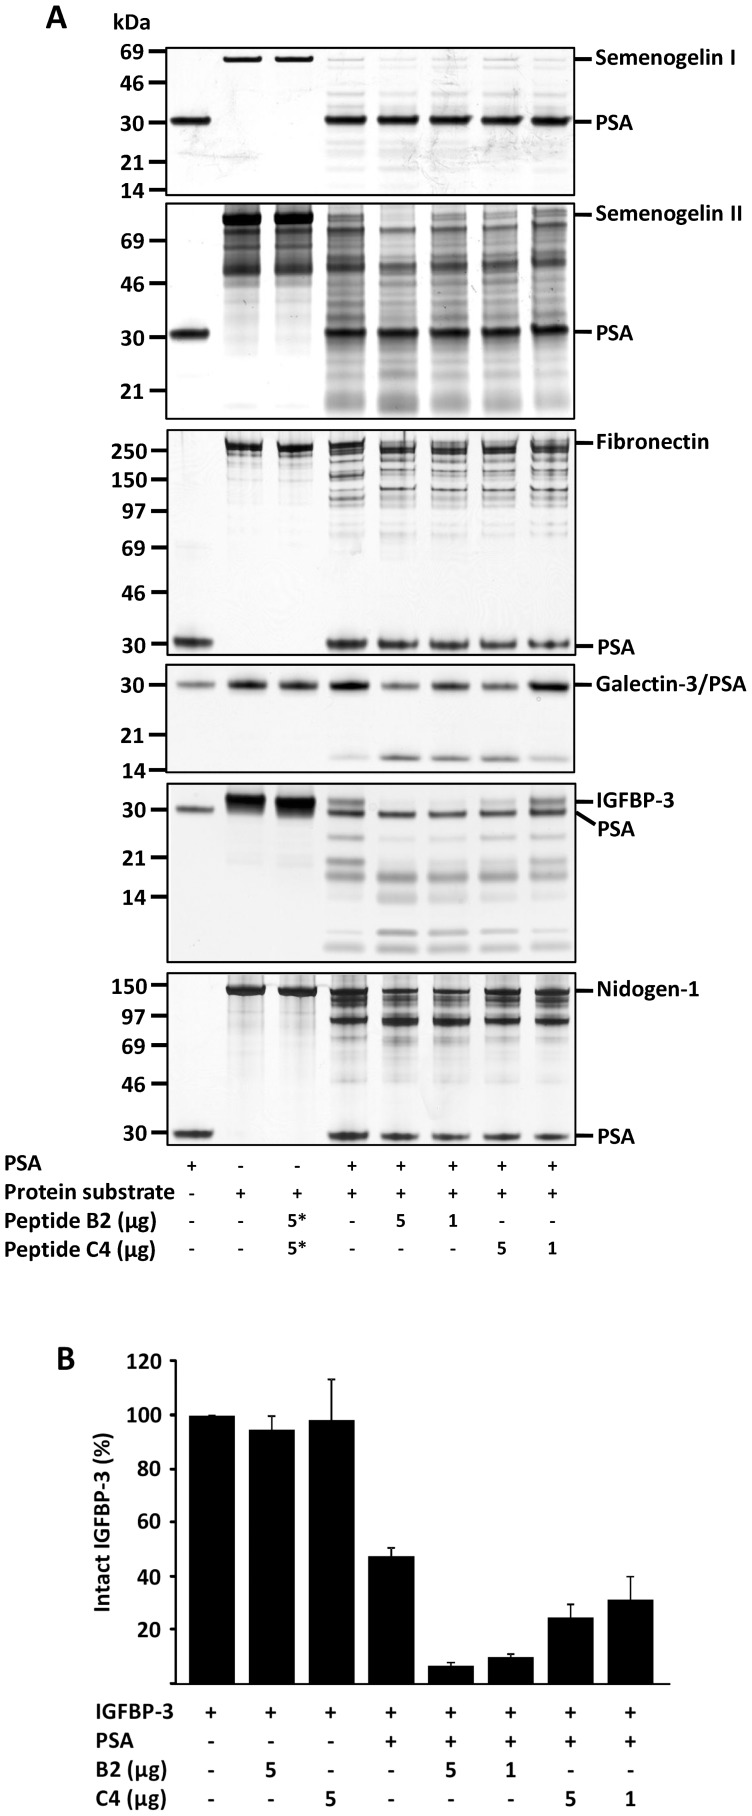
The effect of peptides on the proteolytic cleavage of different protein substrates by PSA.(A) Peptide B2 enhanced the activity of PSA towards all protein substrates more strongly than C4, except for fibronectin this could not be detected. The peptides were preincubated with 0.2 µM PSA for 30 min prior to addition of 0.3–2.5 µM protein substrates and the cleavage of the proteins was detected after 10 min (semenogelin I), 40 min (semenogelin II), 4 h (fibronectin and nidogen-1) and 20–22 h (galectin-3 and IGFBP-3) incubation at 37°C. The notation 5* indicates that 5 µg of either peptide (with semenogelins I and II peptide C4, and with the other proteins B2) was added to the control sample. (B) Concentration of intact IGFBP-3 after incubation with PSA and peptides shown in relation to IGFBP-3 control without added PSA as measured by immunofluorometric assay that recognizes only intact, not cleaved IGFBP-3 (n = 2, mean ± SD).